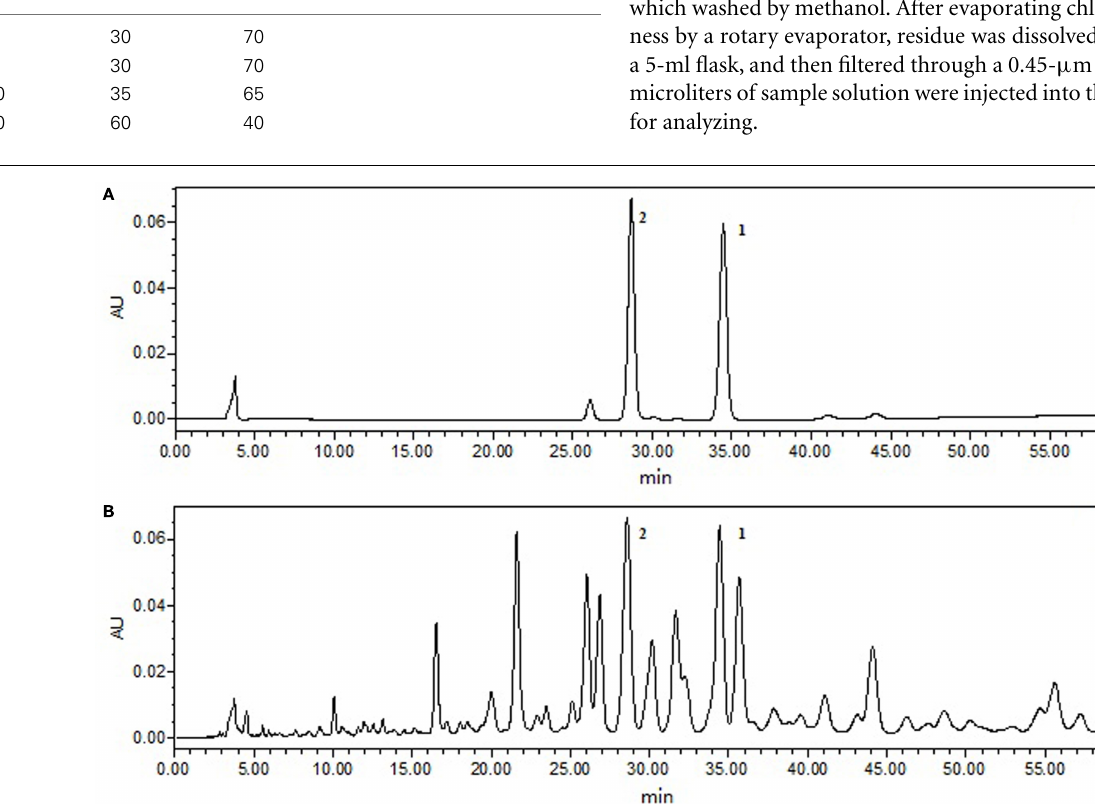
Table 1 | Effect of different time of elution gradient ratio.